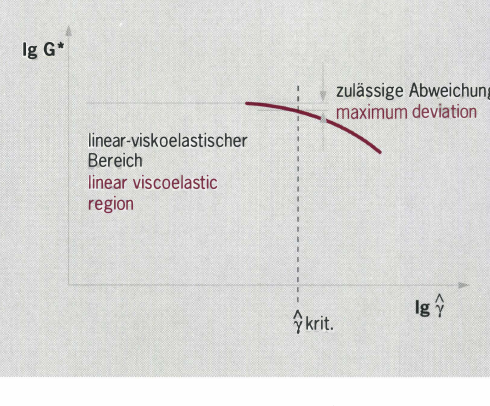
Fig.l: Strain, shear rate and shear stress during a dynamic experiment